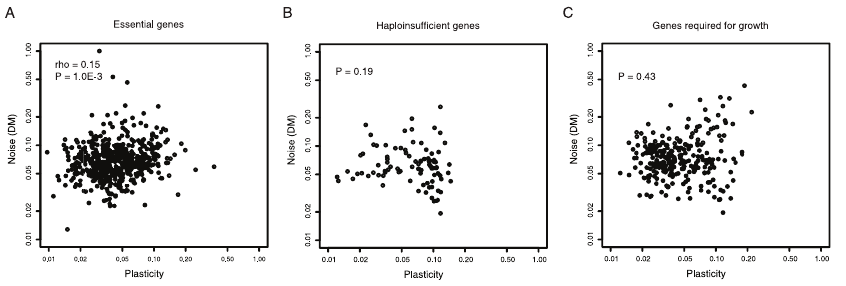
Figure 3. Low noise–plasticity coupling for core cellular components. The correlation between gene expression noise and gene expression plasticity is shown for essential genes (A), haploinsufficient genes (B), and genes required for growth (C). Noise and plasticity data are scaled between 0 and 1. Spearman rank correlation coefficients (rho) and P-values are shown for each gene class.